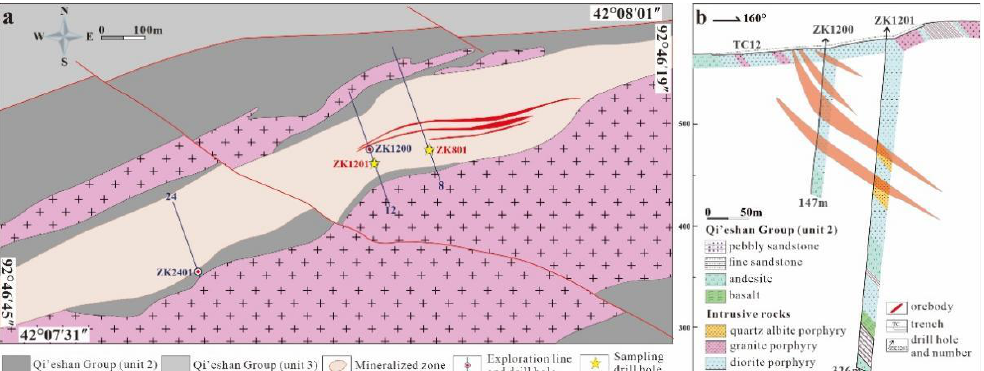
Figure 4. ( a ) Simplified geological map of the Linglong porphyry Cu deposit (modified from [14]). ( b ) Geological section along the No. 12 exploration line on map in (a) with lithology and orebodies (modified from [14]).